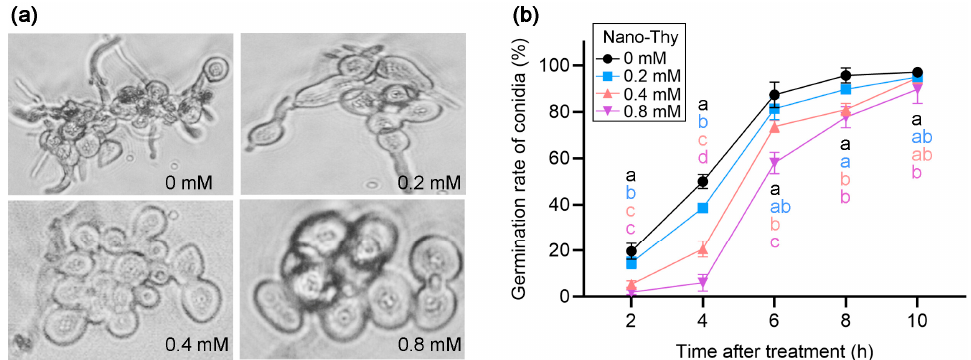
Figure 5. The effect of Nano-Thy on conidial germination of B. cinerea . ( a ) Time-course monitoring of the germination rate of conidia in the presence of Nano-Thy at different concentrations. Different lowercase letters for each time point indicated significant difference among treatments (ANOVA, n